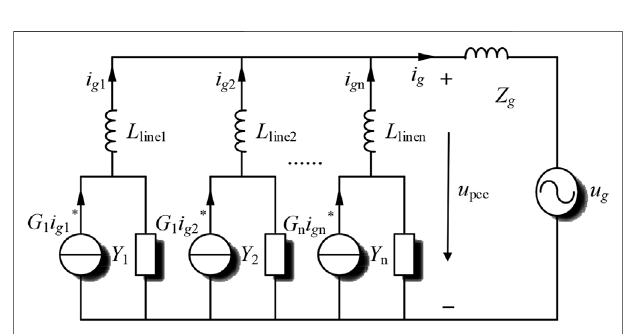
FIGURE 3 | Norton equivalent model.